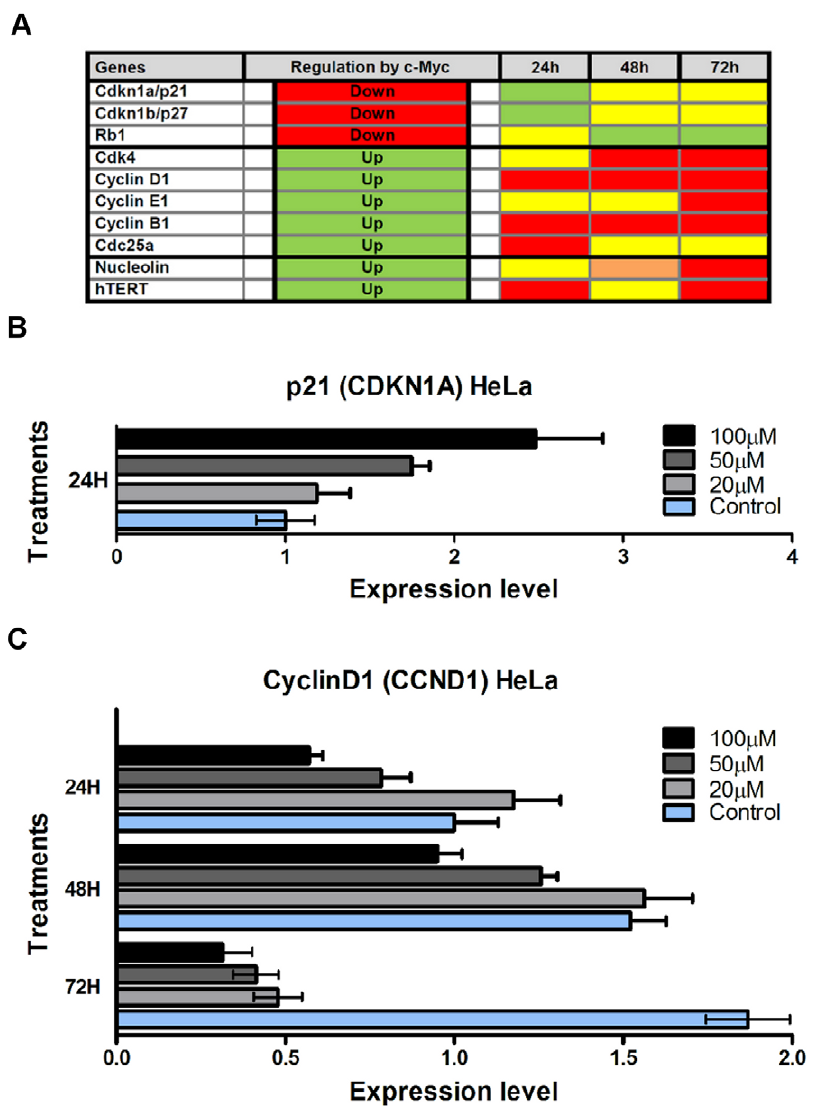
Figure 8. Max* inhibits c-Myc transactivation and repression of transcription. A) Table summarizing qPCR measurement of the effect of a treatment with Max* on a subset of repressed (second column, red) and activated (second column, green) c-Myc target genes in HeLa cells. Green and red boxes indicate statistically significant dose-dependent activation and repression in transcription, respectively. Yellow boxes indicate no statistically significant trend. Orange boxes indicate non-statistically significant repression. Representative results are shown in B) and C) for activated (p21) and repressed (Cyclin D1) genes by Max*, respectively.